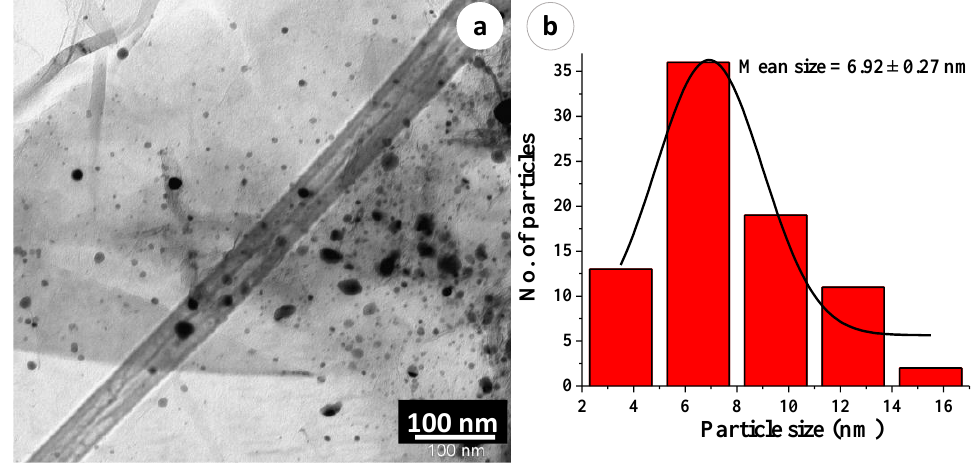
Figure 4. ( a ) High-resolution transmission electron microscope (TEM) images and ( b ) particle size distribution of the NDG@Pd nanocatalyst.